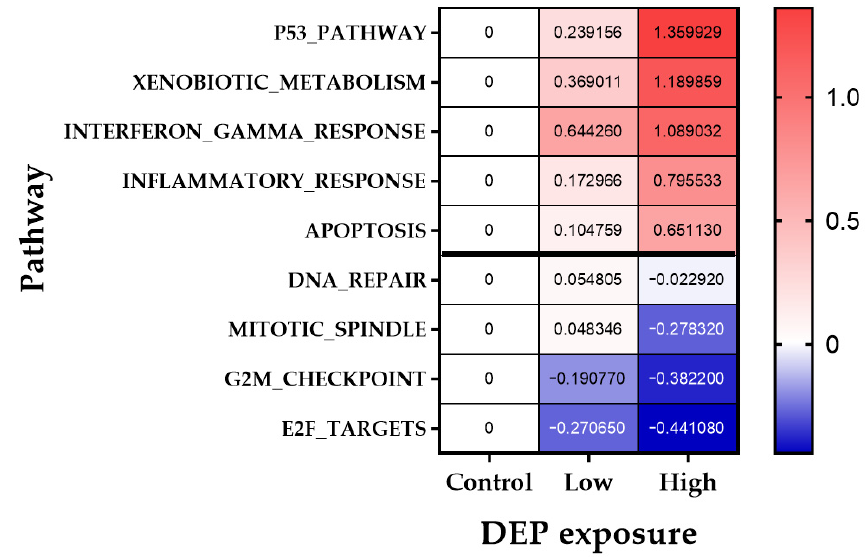
Figure 6. Heatmap of gene set expression of hallmark pathways of interest. Heat map representing the log 2 fold change values between unexposed control and DEP treatment in the human lung embryo fibroblast (WI-38) cells. Low: 100 µg/mL DEP; high: 200 µg /mL DEP.